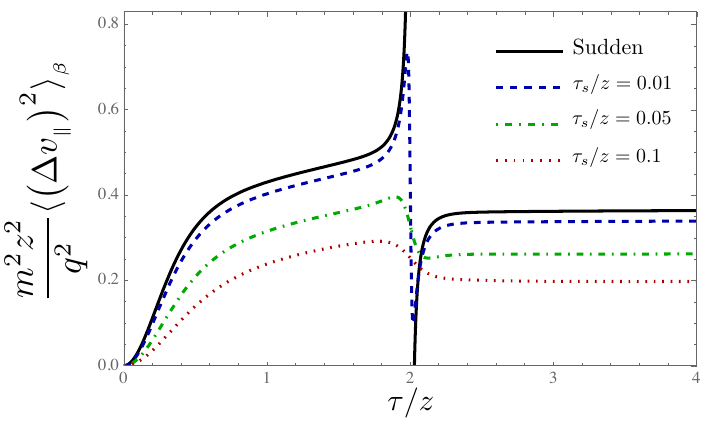
FIG cooling - beta/z = 6.29, tau_s/z = 0.01 Figure 6 . Behaviour of the parallel component of the (cid:12)nite temperature dispersion as function of time (cid:28)=z for some values of switching time (cid:28) s =z . In this (cid:12)gure we choose (cid:12)=z = 0 : 5.